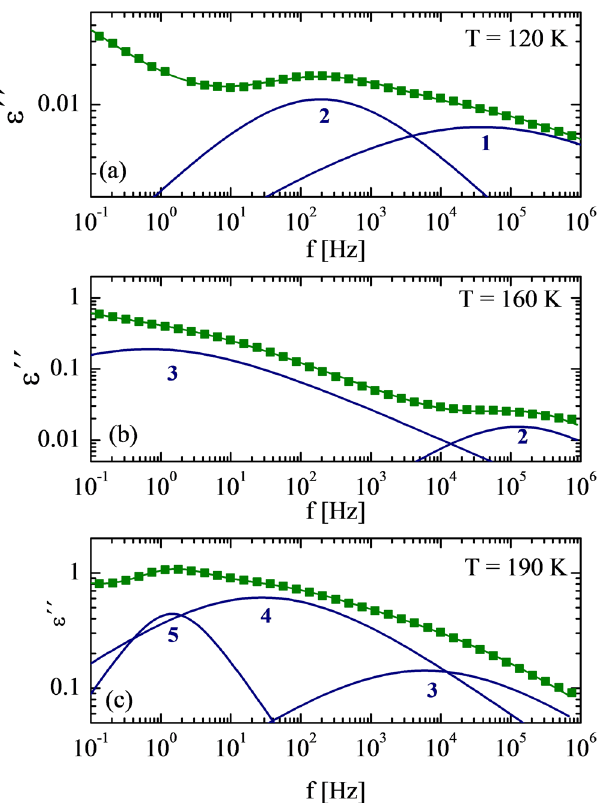
Figure 3. Imaginary part ( ε ″ ) of the dielectric spectra of Portland cement at w / c = 0.3 after three weeks of preparation. ( a ) T = 120 K and ( b ) T = 160 K, ( c ) T = 190 K. The solid lines through the data points represent the fits to the experimental data. Individual processes (1 to 5) for sample w / c = 0.3 are also